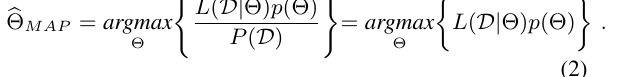
Figure 3. Top: A photo of the target building; Bottom: The reconstructed colored 3D point Figure 2. Orientation estimation for images from different sources: The pyramids show the orientations with the colors representing different cameras (calibration). Cameras are linked with colored line segments (bottom) if the corresponding images overlap.